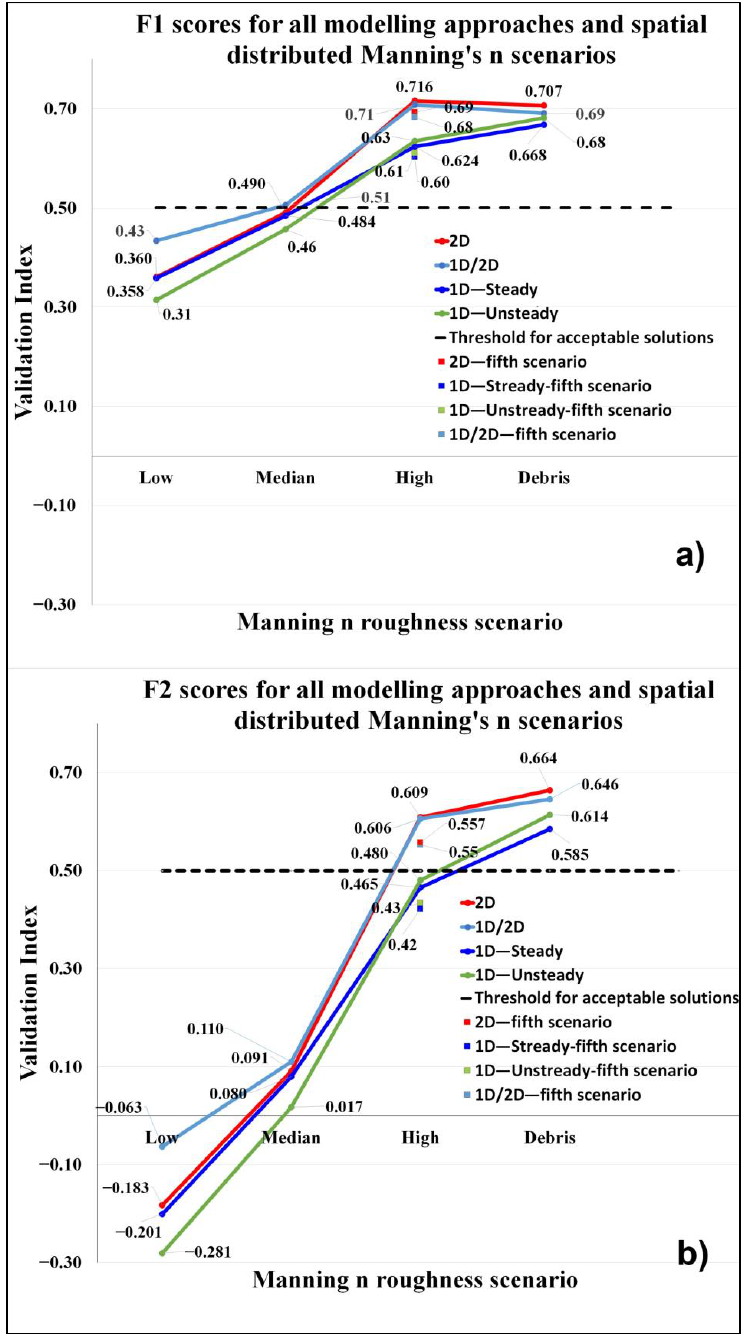
Figure 10. Graph with values of the validation indices F1 and F2 for all examined scenarios and modeling approaches: ( a ) F1 scores, ( b ) F2 scores.